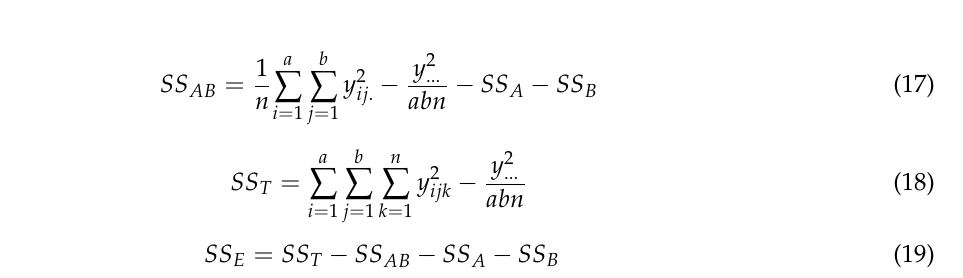
Table 1. Final value range of sensitivity parameters.